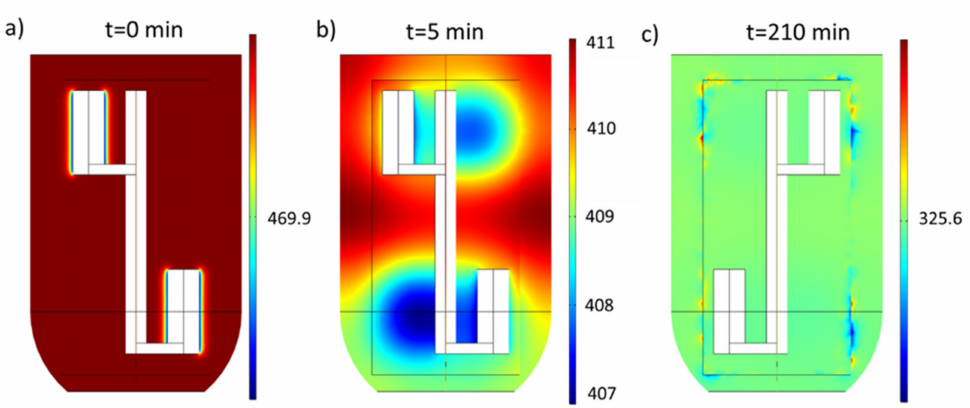
Figure 9. Pyridine concentration profiles in the solution (mg/L) as a function of time ( a ) 0 min, ( b ) 5 min, ( c ) 210